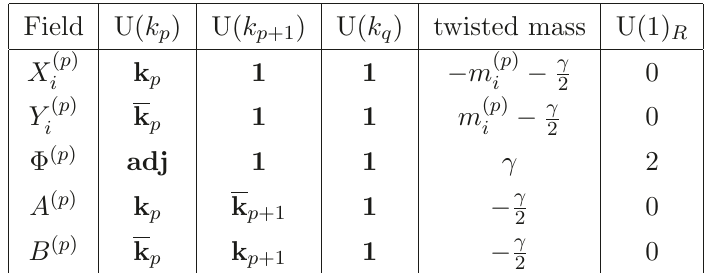
Figure 1 . A M linear quiver with the matter content in table